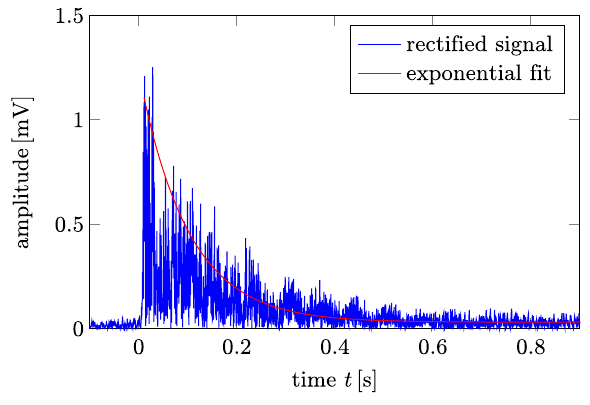
FIG. 14. The 3D diagram shows how the Fourier amplitudes of the three typical frequency distributions decaying in time.